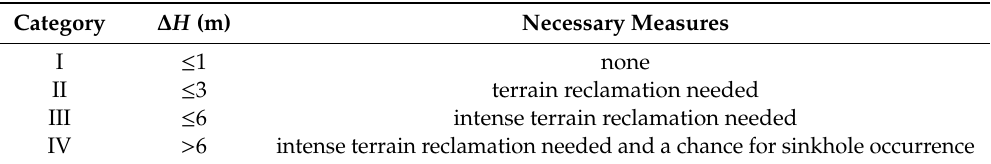
Table 5. Categorization of sectors by the size of occurred subsidence before consolidation is reached and the necessary measures of terrain